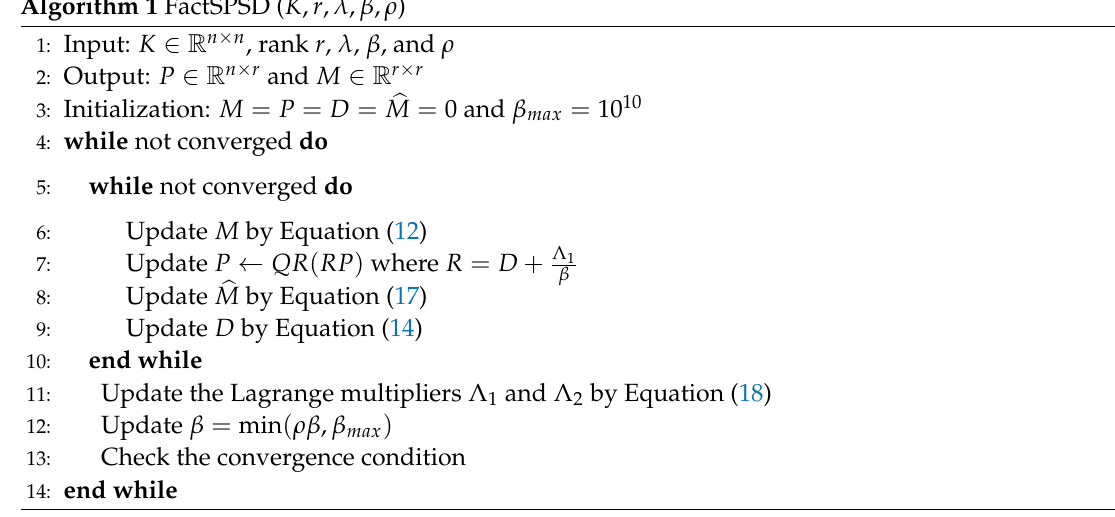
Algorithm 1 FactSPSD ( K , r , λ , β , ρ